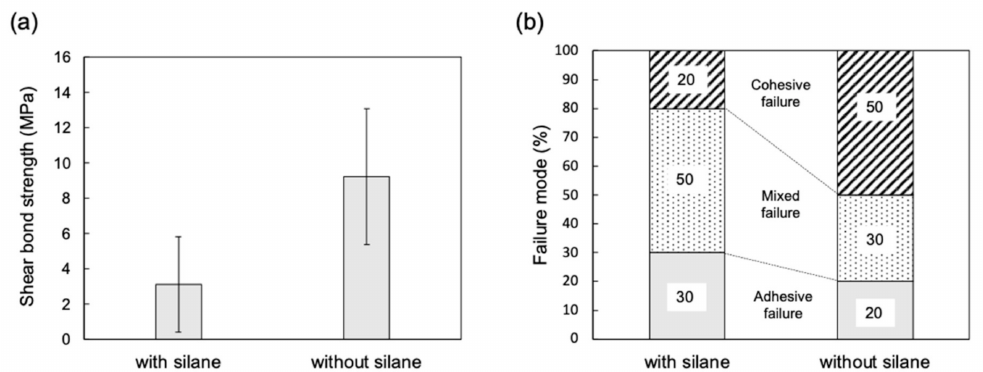
Figure 4. Bonding properties of the SiO 2 /pHEMA-based composite. ( a ) Shear bond strengths between the composite and the dental adhesive with/without the silane primer. ( b ) Sample failure modes after shear bond strength